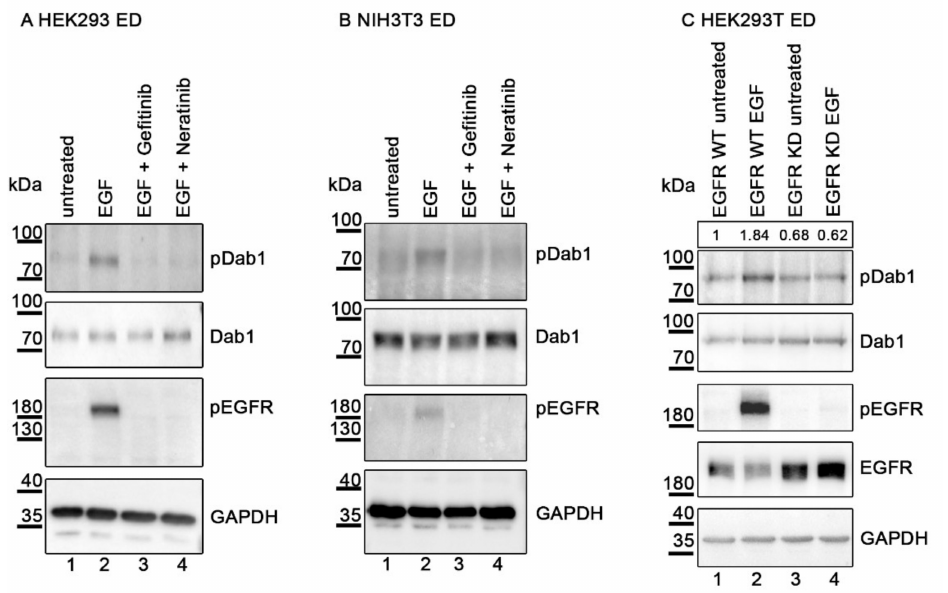
Figure 3. Dab1 phosphorylation depends on EGFR kinase activity. Western blot analysis of protein extracts from HEK293 ( A ) and NIH3T3 ( B ) cells expressing EGFR and Dab1. Inhibitors of EGFR phosphorylation, Gefitinib (Lane 3) and Neratinib (Lane 4) were added 2 h before EGF treatment (3 min at 37 ◦ C). Lane 1 represents untreated negative controls, Lane 2 represents the EGF treated positive controls. Immunoprecipitation using a Dab1 specific antibody was performed (Ab 54). ( C ) Western blot analysis of protein extracts HEK293T expressing Dab1 and either a wild type (WT)- like EGFR or a kinase-dead (KD) EGFR. Lanes 1 and 3 represent the untreated negative controls and Lanes 2 and 4 represent EGF treatment. Immunoprecipitation using a Dab1 specific antibody was performed (Ab 54). Bands were scanned with ChemiDoc Touch Imaging System (BioRad, Hercules, CA, USA) and the anti-phosphotyrosine signal was normalized to the anti-Dab1 band. The level of Dab1 phosphorylation in the untreated WT EGFR (lane 1) control was set to 1. Relative intensity is shown in a box above the first panel. Dab1 phosphorylation levels (Panel 1) were detected using an antibody against phosphorylated tyrosine residues (Ab PY99). The blots were stripped and re-probed for Dab1 using Ab D4 (Panel 2). Extracts were blotted with an antibody specific for phosphorylated EGFR (Tyr 1173) (Panel 3) and EGFR (C, Panel 4). As a loading control GAPDH was used (Panel 4 in A and B or 5 in